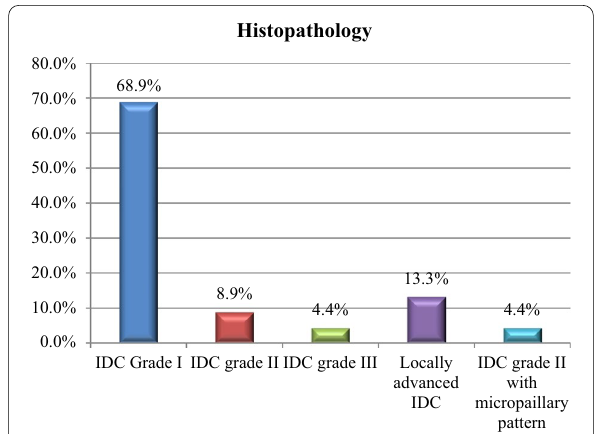
Fig. 1 Histopathology distribution of the breast lesions among study